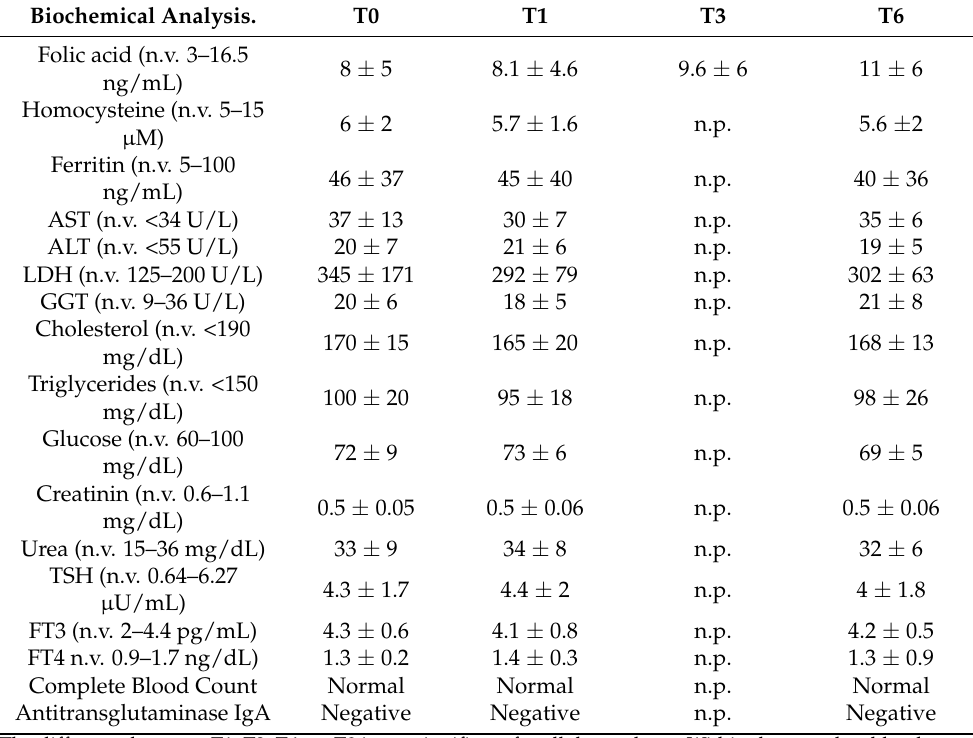
Table 3. Biochemical profiles of DS children treated with EGCG for 6 months (Group 1). Biochemical Analysis.